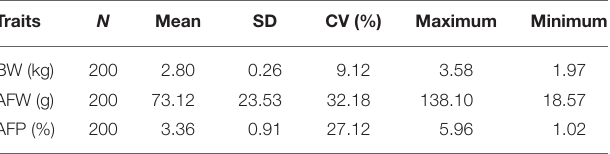
TABLE 2 | Descriptive statistics for Muscovy duck phenotypes.